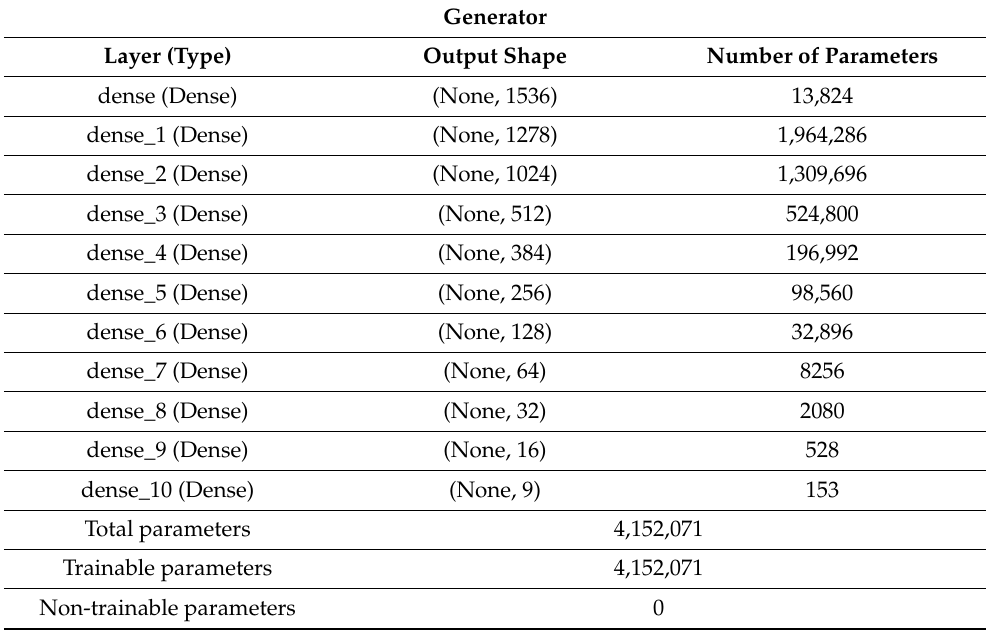
Table 2. Generator model output.